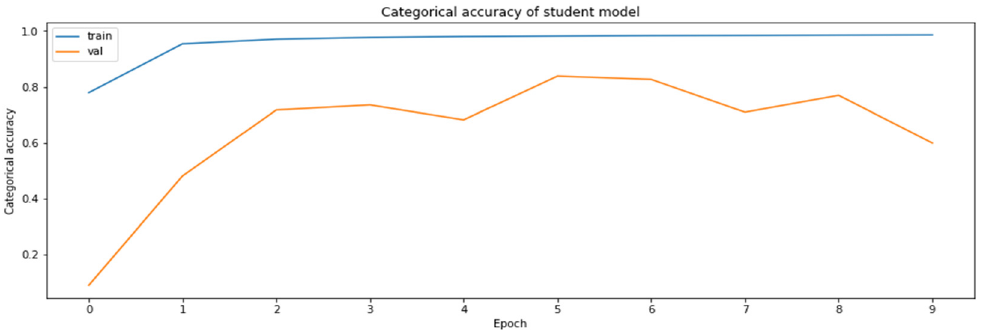
Figure 14. The accuracy of the model for the validation datasets obtained during the model distillation process.